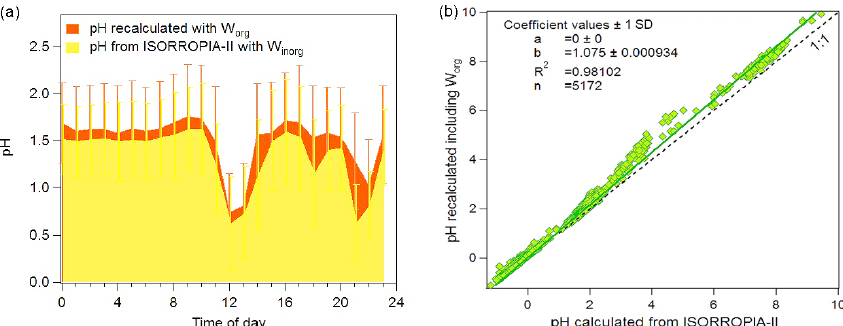
Figure 6. Panel (a) : diurnal variability of pH based on total predicted water (orange, using both W org and W inorg ) and only the inorganic water (yellow, using only W inorg ) ; average hourly values and standard deviation in the form of error bars are provided. Panel (b) : compar- ison between the pH predicted by ISORROPIA-II based on inorganic aerosol composition and that recalculated including also the organic